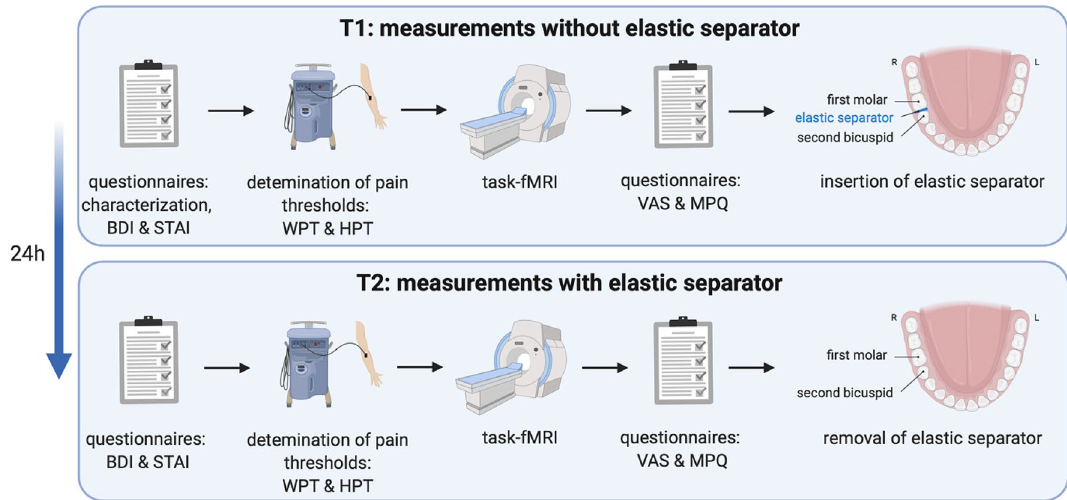
Figure 1. Study design. L left, BDI Beck’s Depression Inventory, WPT warmth perception threshold, HPT heat pain threshold, MPQ McGill-Pain Questionnaire, R right, STAI State and Trait Anxiety Inventory, VAS Visual Analogue Scale; Figure created with